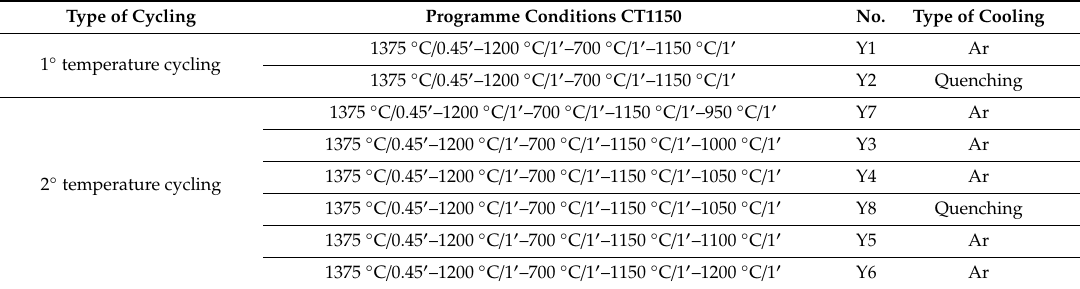
Table 2. Temperature cycling conditions in the stable austenite temperature zone (CT1150).